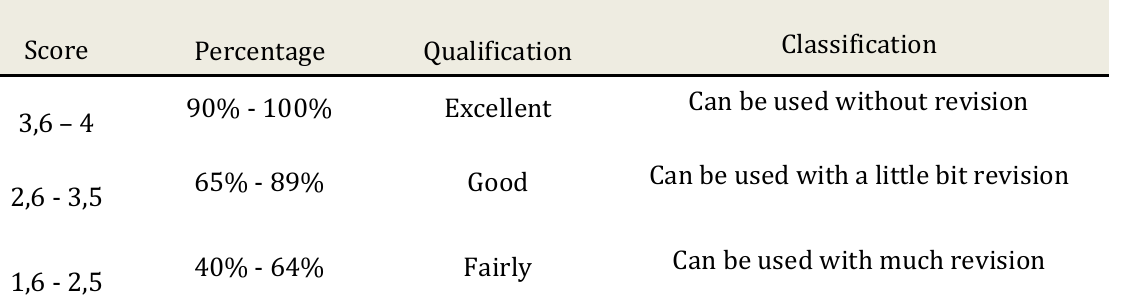
Table 3.1: Classification Students’ Perception about the Syllabus